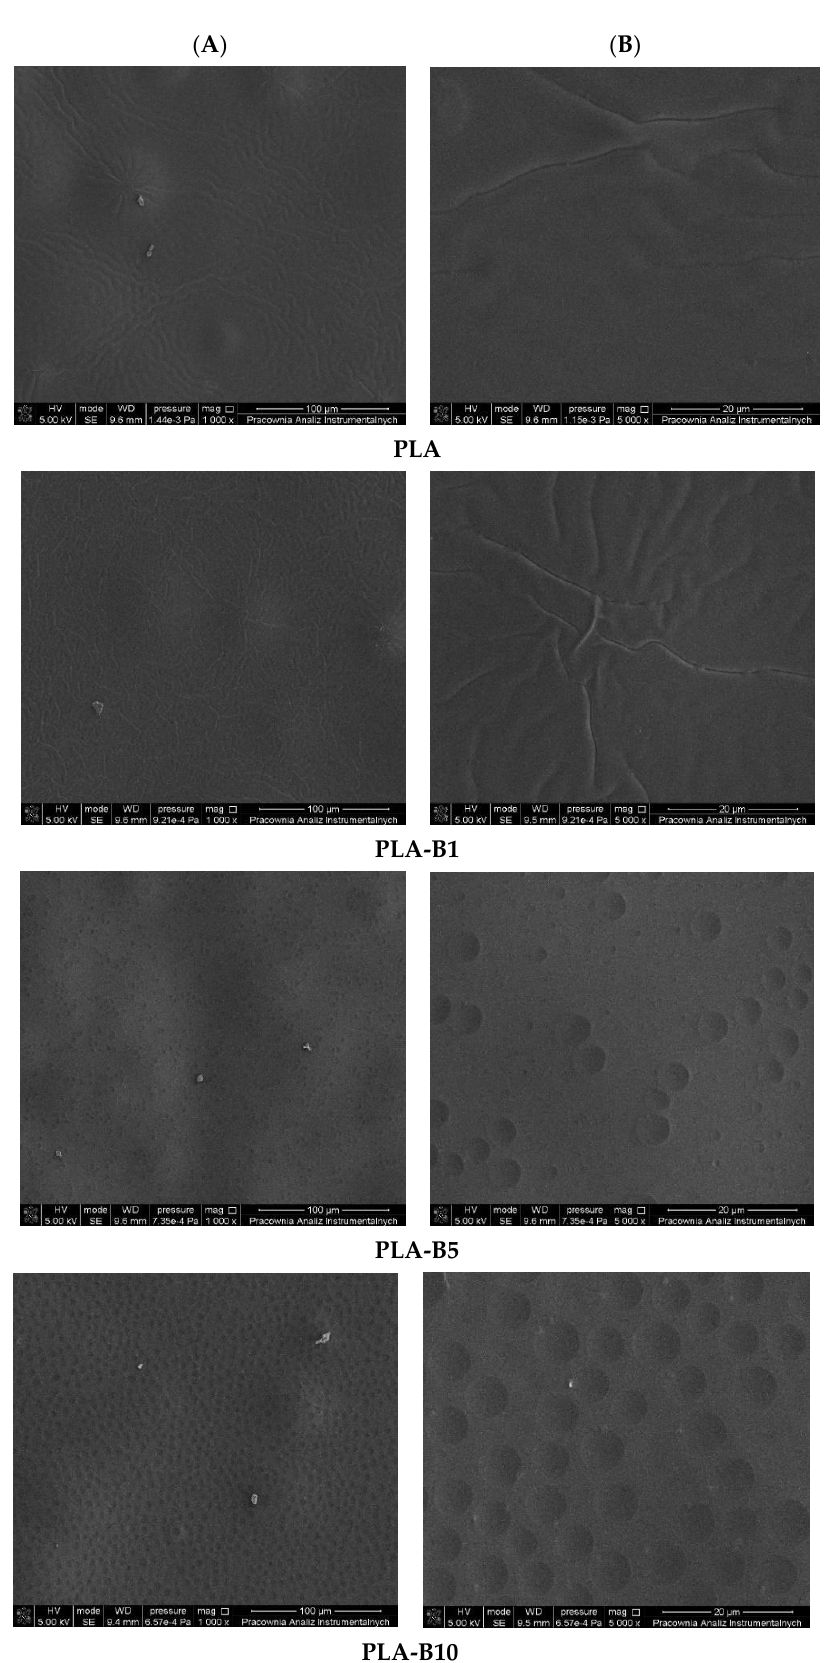
Figure 2. SEM analysis of surface of PLA and PLA with birch tar (PLA-B1–PLA-B10) materials, magnifications of 1000× ( A ) and 5000× ( B ).